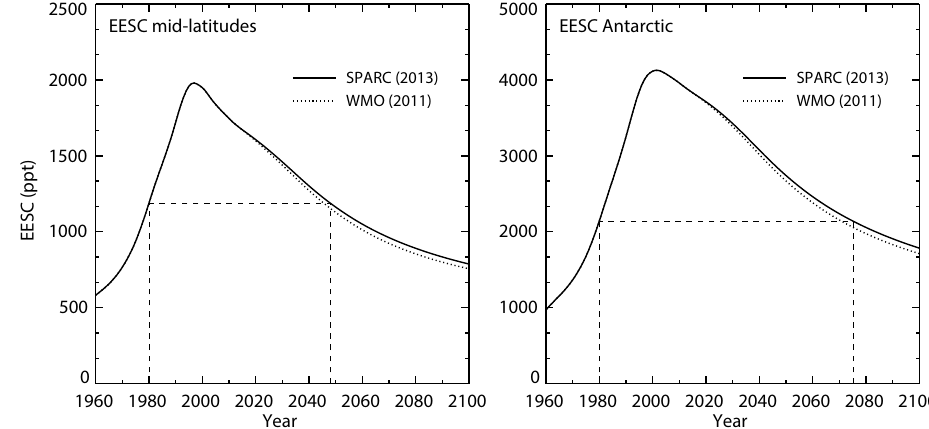
Fig. 2. EESC for midlatitude (left) and Antarctic (right) conditions based on lifetimes from SPARC (2013) and WMO (2011). The thin dashed lines indicate the 1980 EESC levels and the years the EESC curves cross these levels for the cases using the SPARC (2013) lifetimes.